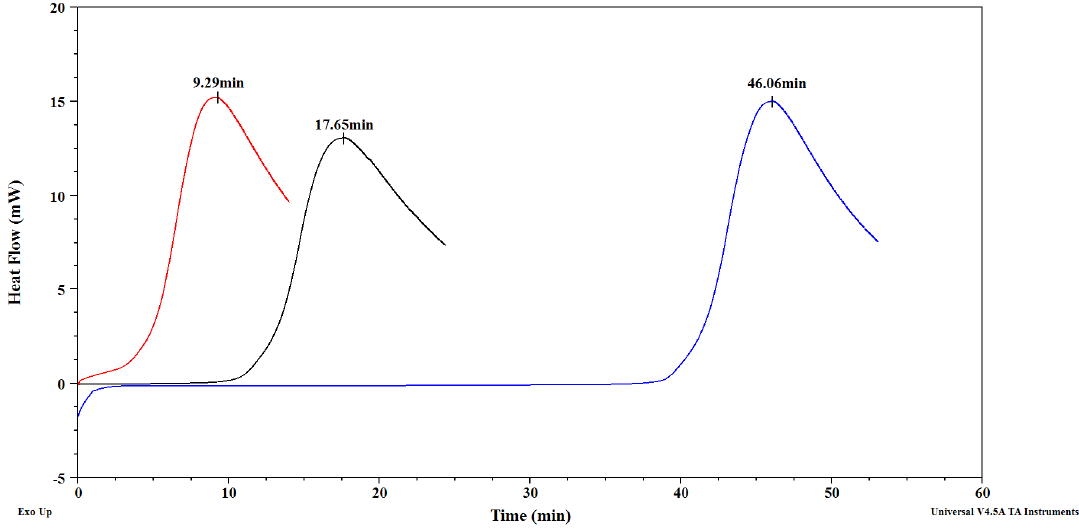
Figure 2. Exemplary pDSC curves of oxidation induction time for cranberry (blue), black currant (black) and strawberry (red) seed oils at 120 °C.